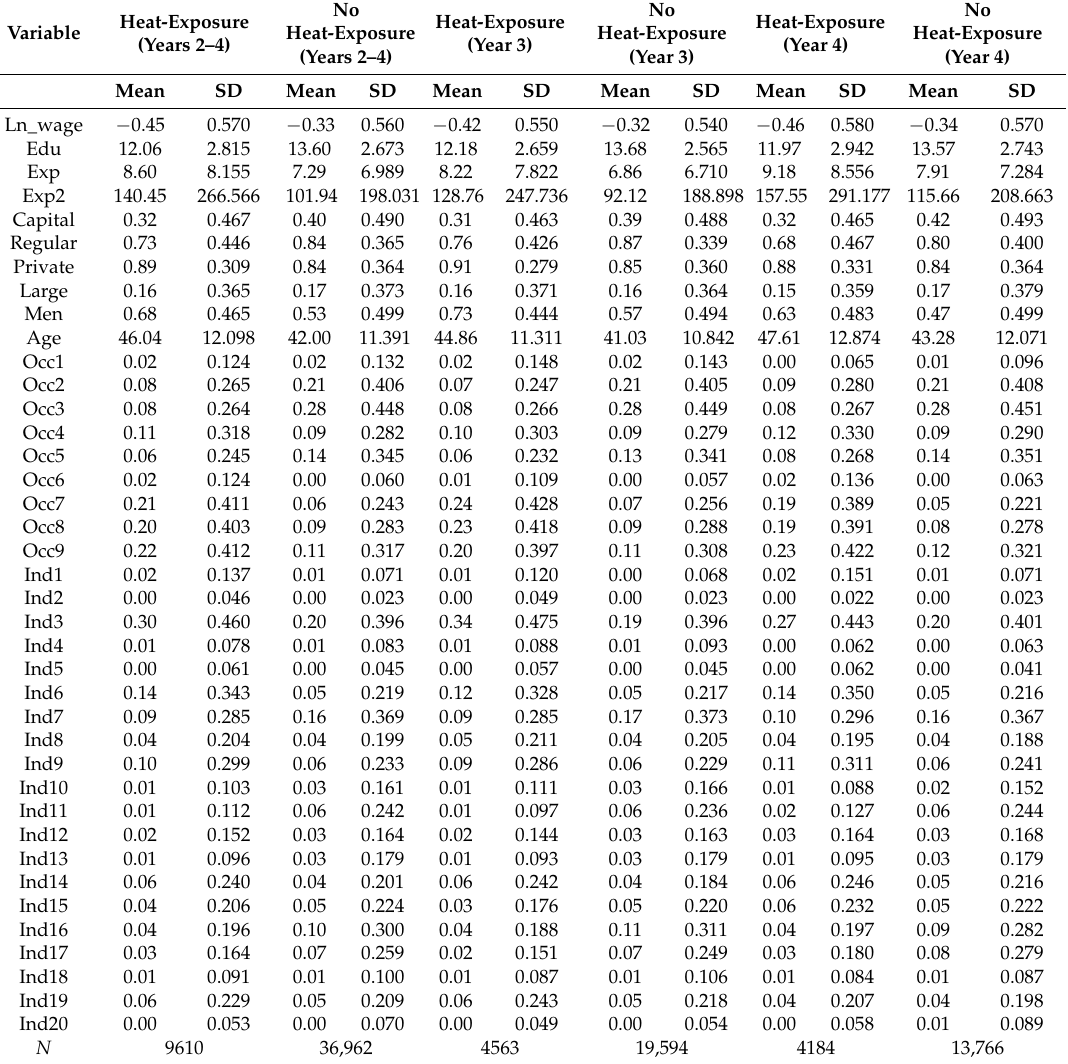
Table 2. Descriptive